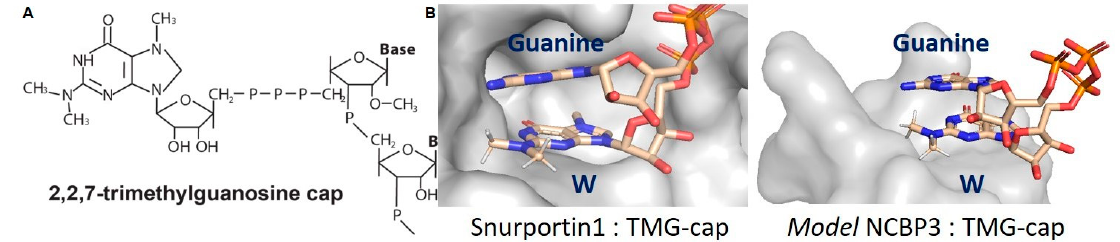
Figure 5. The hypermethylation of the m 7 G-cap eliminates capacity for Watson-Crick base pairing and for CBC/eIF4E/TGS1 binding. ( A ) The 2,2,7 -trimethylguanosine (TMG-cap) appended to the 5 ′ - terminus of RNA. ( B ) Space-filling model of the TMG-binding pocket of Snurportin1 and NCBP3 modeled on the structure of PARN. In each, the TMG-cap exhibits base stacking with the aromatic ring of tryptophan (W) in the polypeptide and guanine in the cognate RNA.